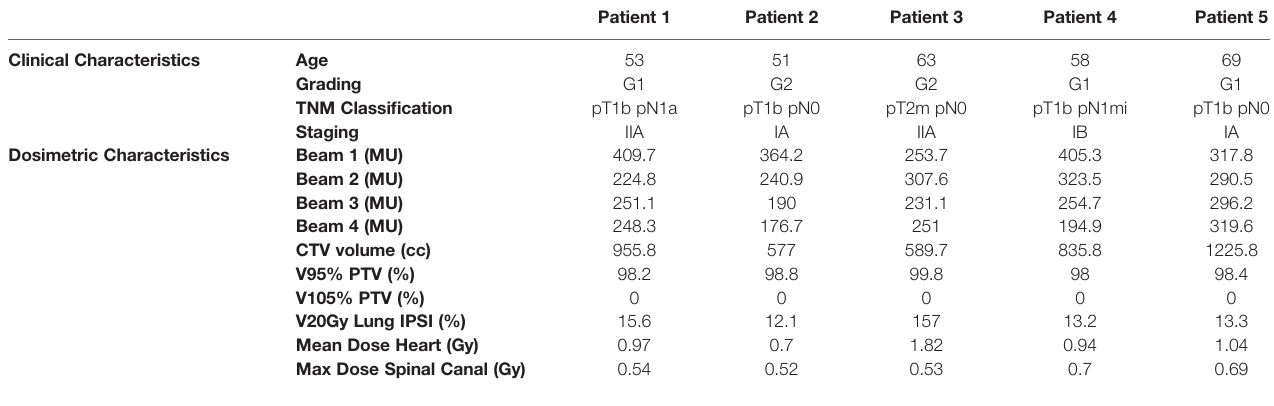
TABLE 1 | Clinical and dosimetric characteristics of the patients analyzed.